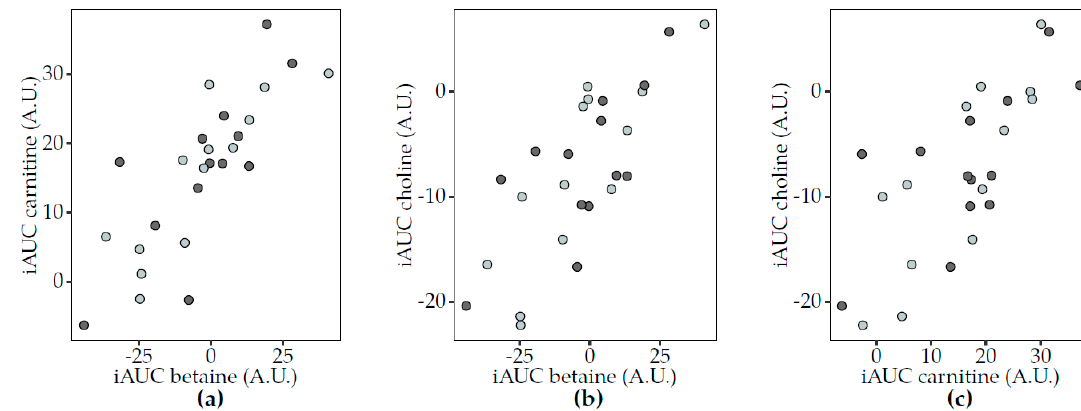
Figure 4. Scatter plots to illustrate associations between the postprandial responses (iAUC) in plasma of selected circulating metabolites to acidified milk (light grey) and yogurt (dark grey) consumption (Study 1). Spearman’s correlation test completed for acidified milk and yogurt (significance for FDR < 0.05) showed positive correlations for ( a ) carnitine and betaine (acidified milk, rho = 0.87, FDR = 0.003; yogurt, rho = 0.74, FDR = 0.03), ( b ) choline and betaine (acidified milk, rho = 0.84, FDR = 0.003; yogurt, rho = 0.63, FDR = 0.05) and ( c ) choline and carnitine (acidified milk, rho = 0.80, FDR = 0.003; yogurt, rho = 0.58, FDR = 0.06). A.U., arbitrary units; FDR, false discovery rate; iAUC, incremental area under the curve. Table 1. Spearman’s correlation between fasting plasma TMAO and relative abundance of microbiota taxa. Family (EzBioCloud) Family (GTDB) Rho p Value FDR